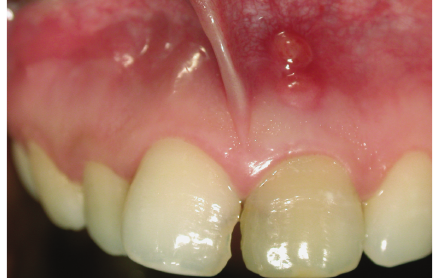
Figure 1: Clinical view of the two fistulas on tooth